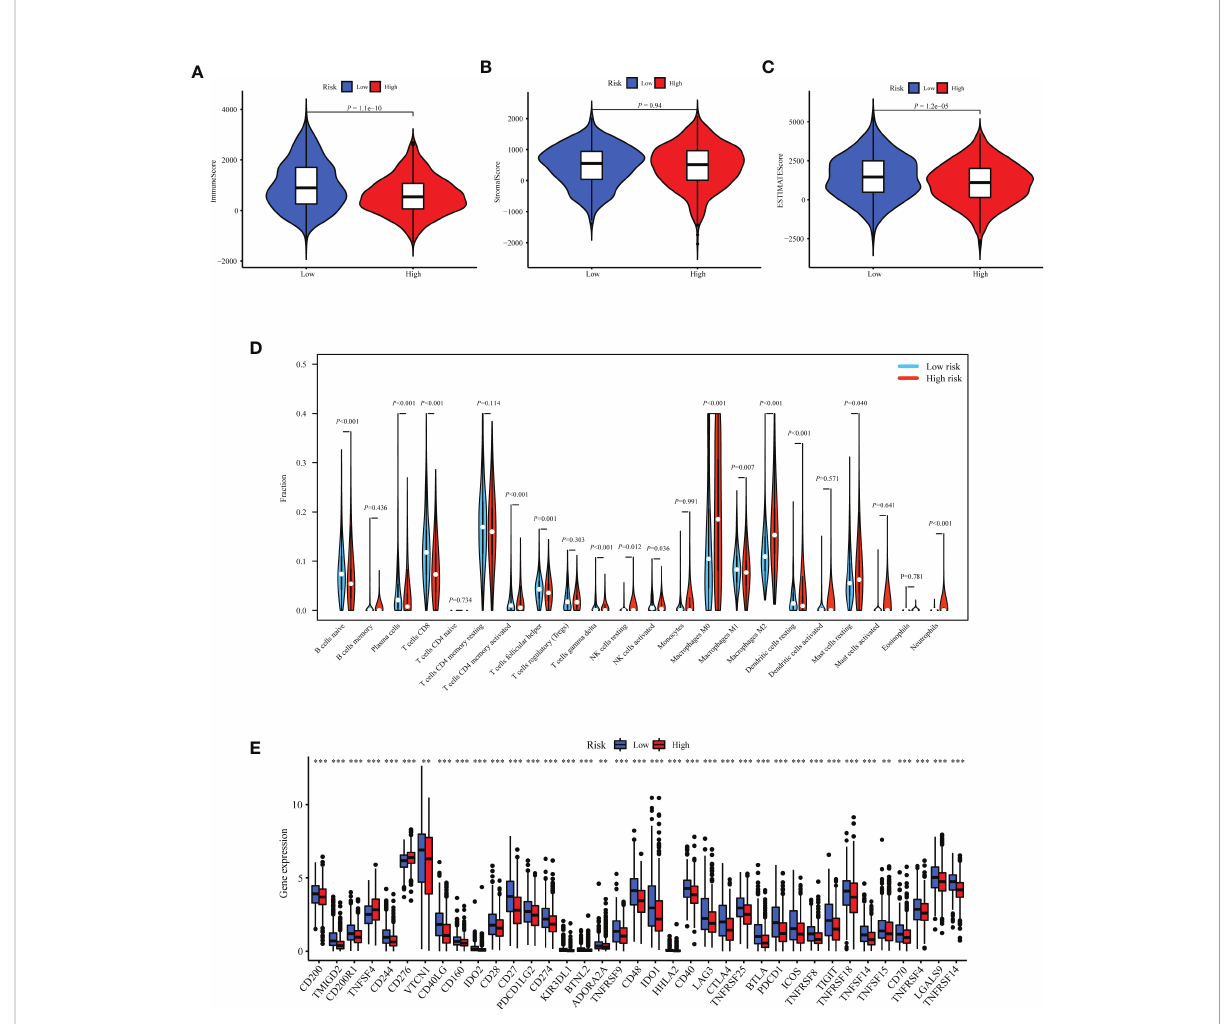
FIGURE 6 Exploration of differences in the tumor immune microenvironment between the high- and low-risk groups of the TCGA-BRCA training cohort. Immune score (A) , stromal score (B) , and tumor purity (C) were evaluated using ESTIMATE analysis and compared between high- and low-risk groups. (D) In fi ltration of 22 kinds of immune cells were analyzed by the CIBERSORT algorithm. (E) Expression of 37 immune regulatory genes were compared between the high- and low-risk groups. ** p <0.01, *** p